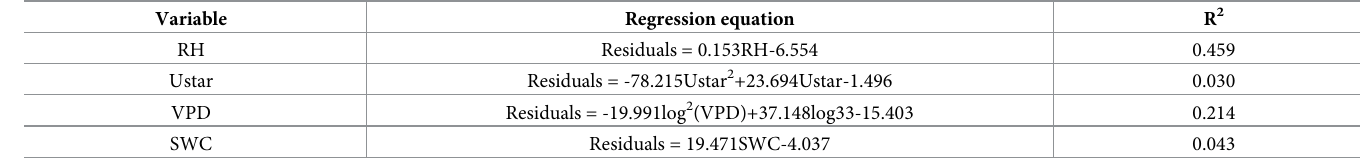
Table 3. Relationships between the residuals from the regression of GPP-T air and environmental variables at the daily time scale. Variable